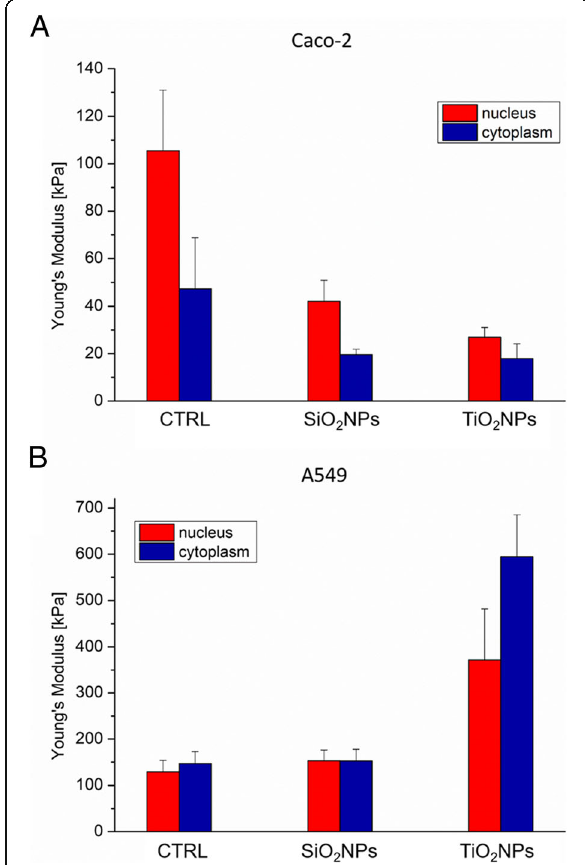
Fig. 10 Young ’ s modulus values expressed in kPa, calculated from the nuclear region and the cytoskeletal area of Caco-2 ( a ) and A549 ( b ) cell lines after a treatment to 45 μ g/ml of SiO 2 NPs and TiO 2 NPs for 72